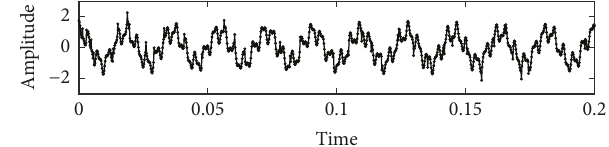
Figure 4: The time domain graph of the simulation signal.